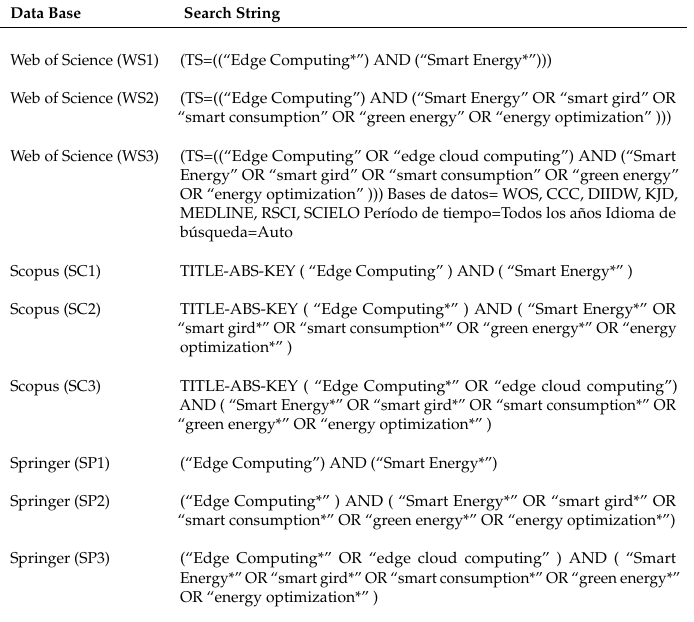
Table 1. Search string designed for database